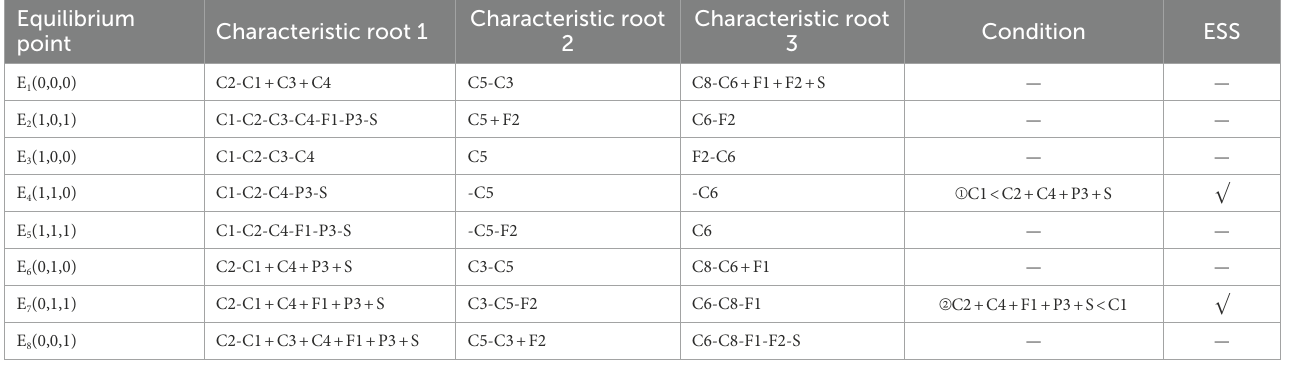
Characteristic root 1